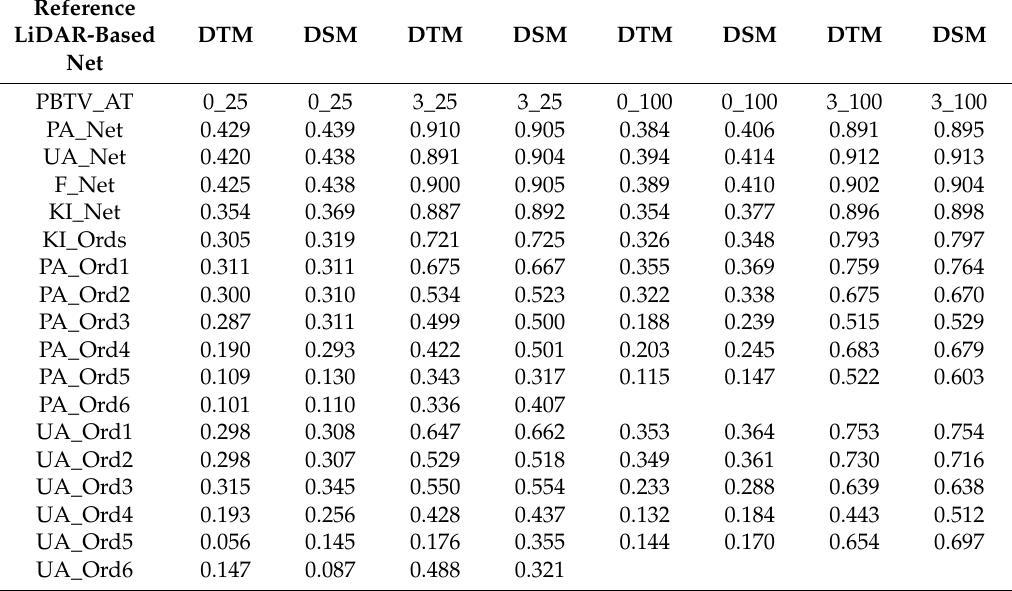
Table 6. Performance accuracy metrics computed based on a comparison between whole channel networks/orders extracted from the LiDAR DTM/DSM 28.5 m and the SRTM DEM 28.5 m at different ATs expressed in the corresponding number of pixels and PBTV in